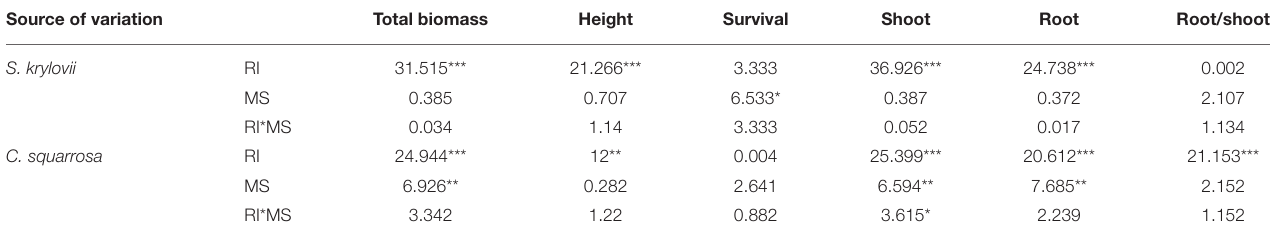
TABLE 2 | Results ( F -values) of two-way ANOVA on the effects of root isolation (RI), management strategy (MS: control, N addition, mowing), and their interactions on total biomass, height, survival, shoot and root biomass, and root/shoot of S. krylovii and C. squarrosa , respectively. Source of variation Total biomass Height Survival Shoot Root Root/shoot